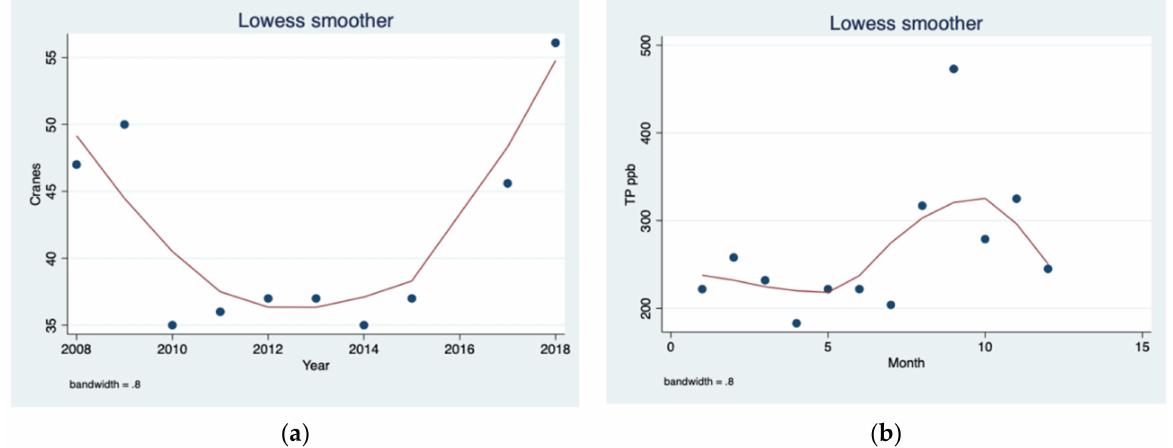
Figure 14. ( a ) Maximum cranes counted (10 3 ). ( b ) LOWESS smoother trend plot of changes in monthly means of TPout (ppb) during 1994–2018.